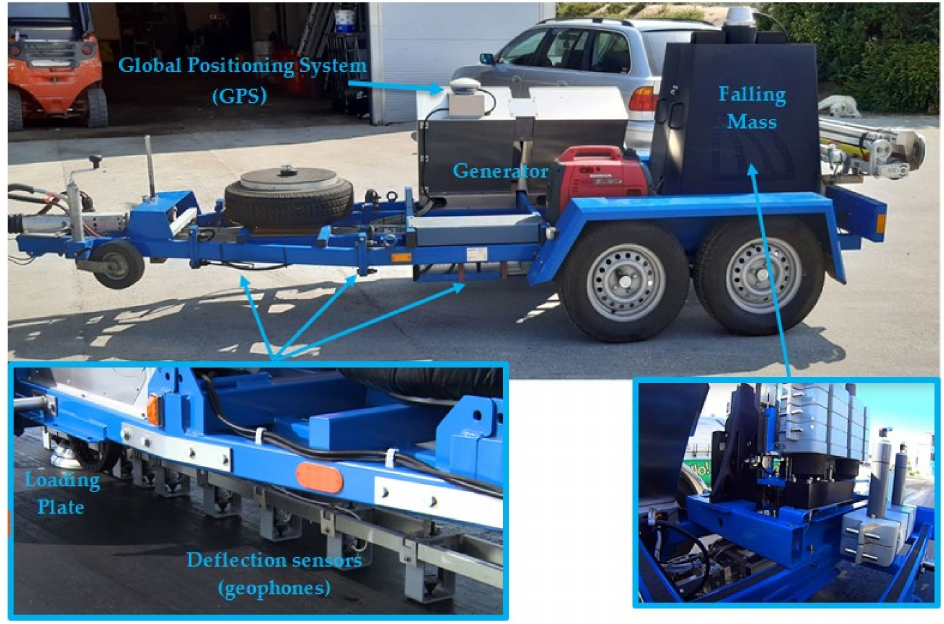
Figure 9. The trailer with the FWD measuring